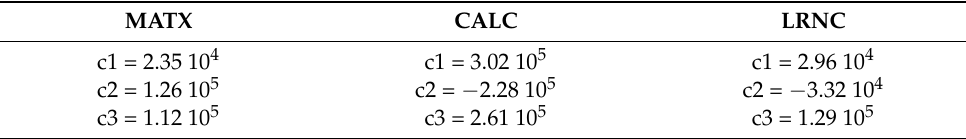
Table 2. Yeoh material parameters prescribed (in Pa) to describe the individual plaque tissue